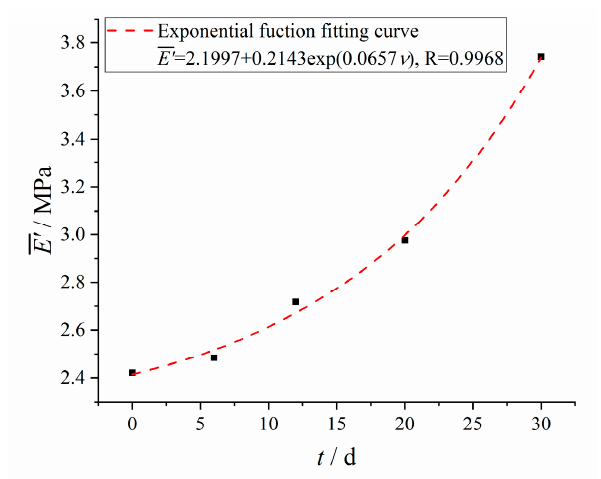
9 of 20 Figure 8. Changing curves of storage modulus and loss modulus with the dynamic strain amplitude at different aging times. ( a ) Storage modulus E ' ; ( b ) Loss modulus E” . At the same time, under the same strain amplitude, the storage modulus and loss modulus of the HTPB coating increased with the increase of aging time, which was mainly due to the increase of the crosslinking density of materials during the aging process, and the connection between molecular chains became a more compact three ‐ dimensional network structure, resulting in the restriction of